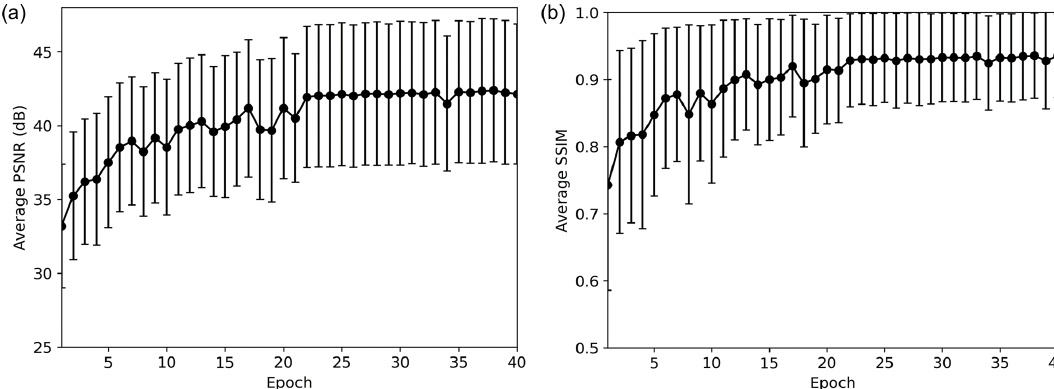
Figure 12. Average (a) PSNR and (b) SSIM with standard deviation of the test result of the second experiment.